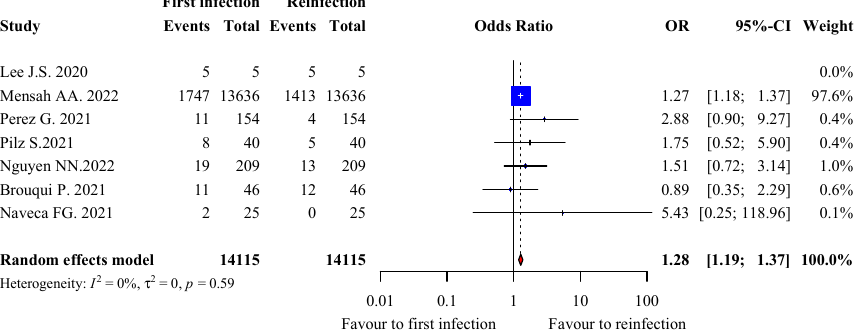
Figure 3. Forest plot of hospitalisations during the first and second infection.